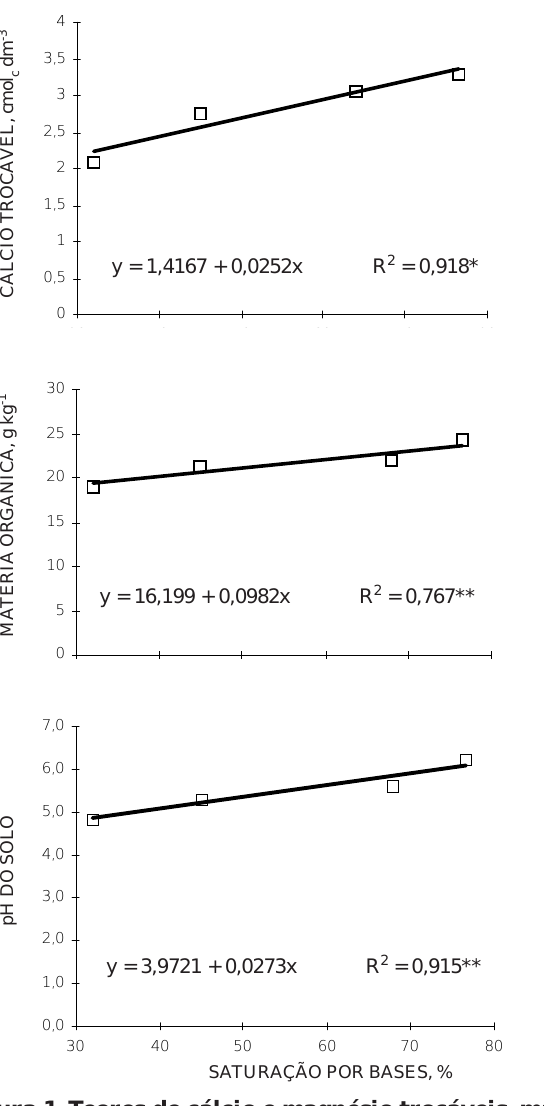
Figura 1. Teores de cálcio e magnésio trocáveis, matéria orgânica, biomassa microbiana-C, pH e fósforo disponível em função da saturação por bases em um solo do tabuleiro costeiro de Umbaúba (SE).